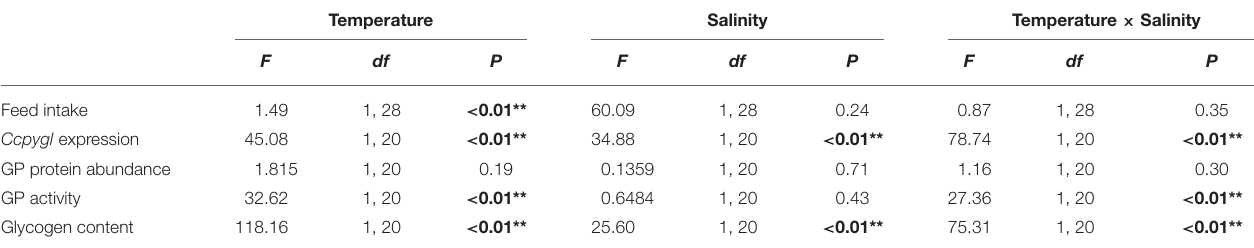
TABLE 4 | Results of two-way ANOVA evaluating the source of temperature and salinity variations in livers of milkfish. Temperature Salinity Temperature × Salinity